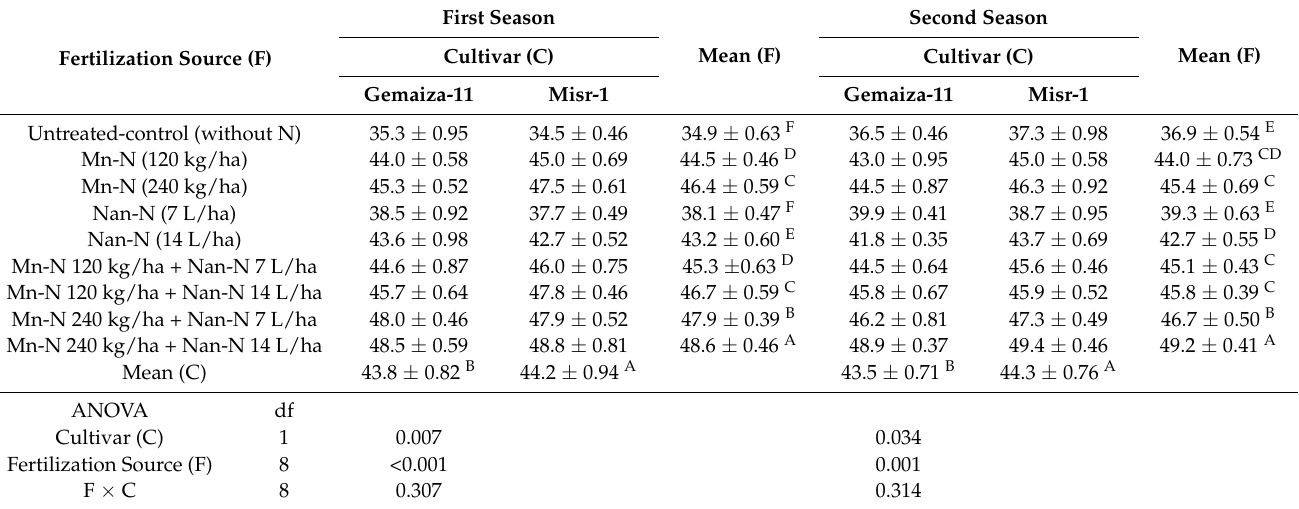
Table 1. Impact of nano and mineral nitrogen fertilizers on total chlorophyll content of two wheat cultivars during 2019/2020 and 2020/2021 seasons.